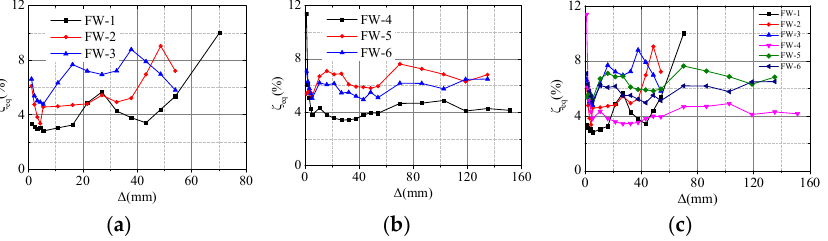
Figure 17. Comparisons of the equivalent viscous damping coefficient: ( a ) Specimens with rigid bracings; ( b ) Specimens with flexible bracings; ( c ) Comparison of all specimens.